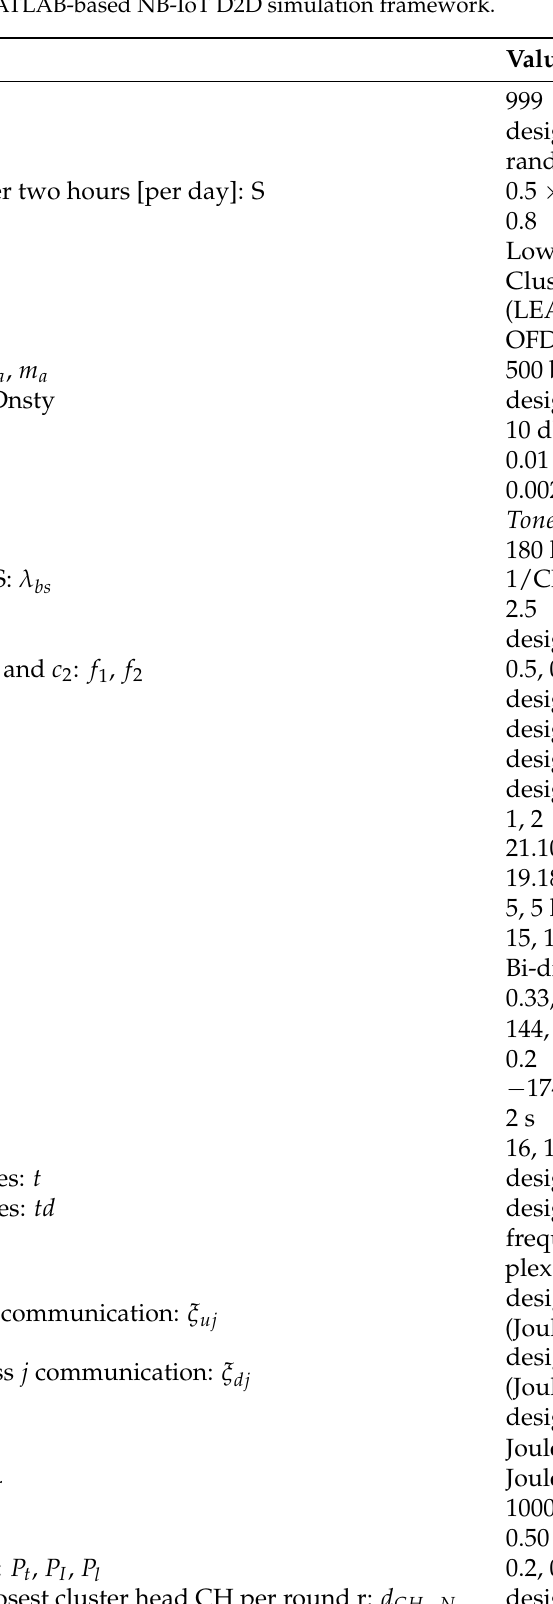
Table 2. Parameters of MATLAB-based NB-IoT D2D simulation